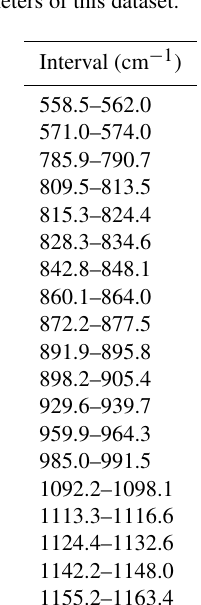
Table B1. Microwindows used in TCWret to retrieve the micro- physical cloud parameters of this